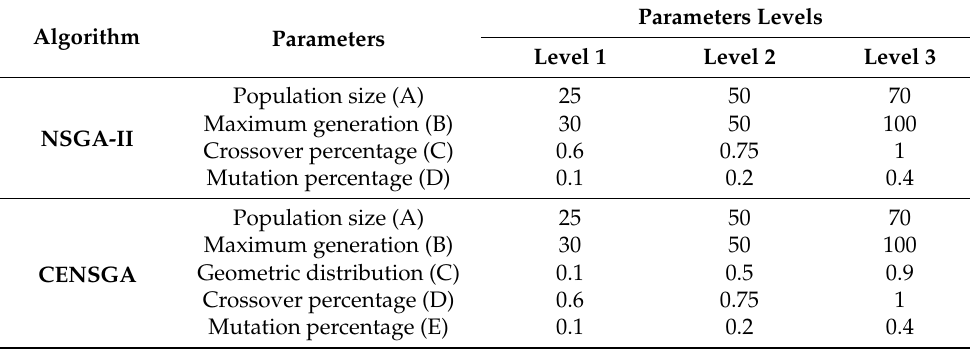
Table 2. The levels defined for the parameters of NSGA-II and CENSGA.